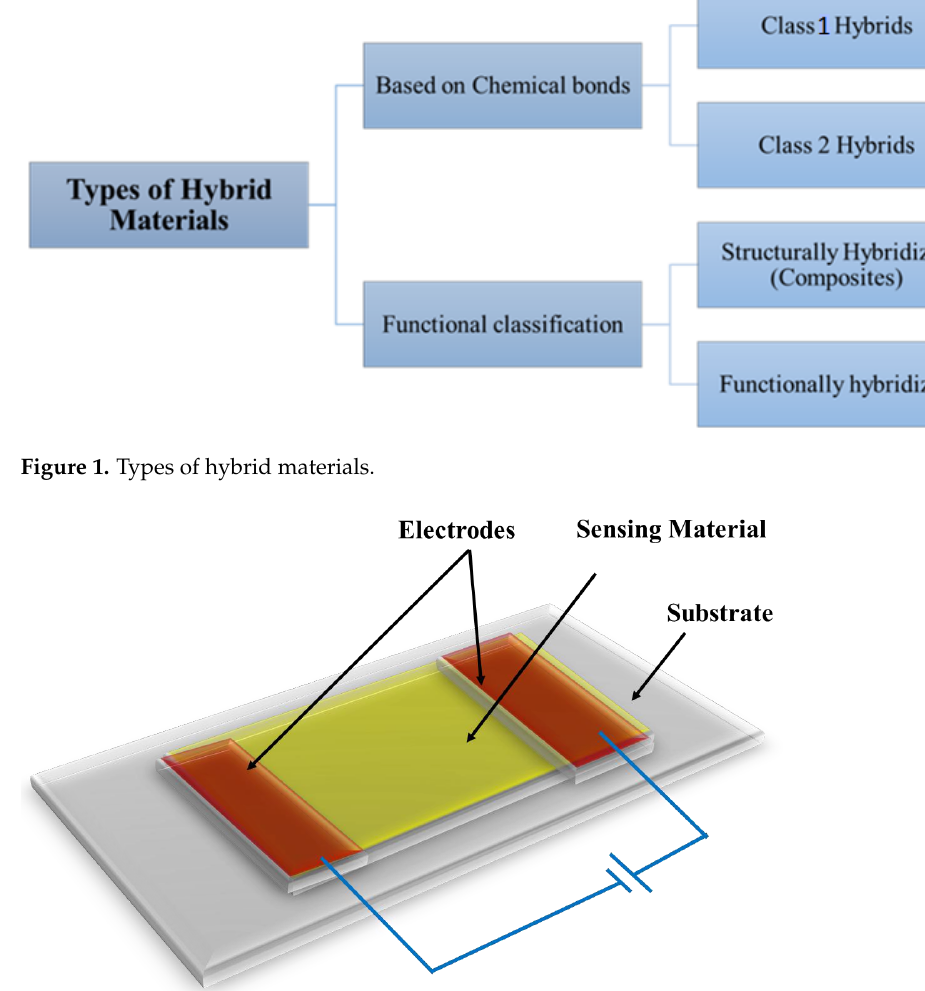
Figure 2. Schematic representation of chemiresistor sensor.